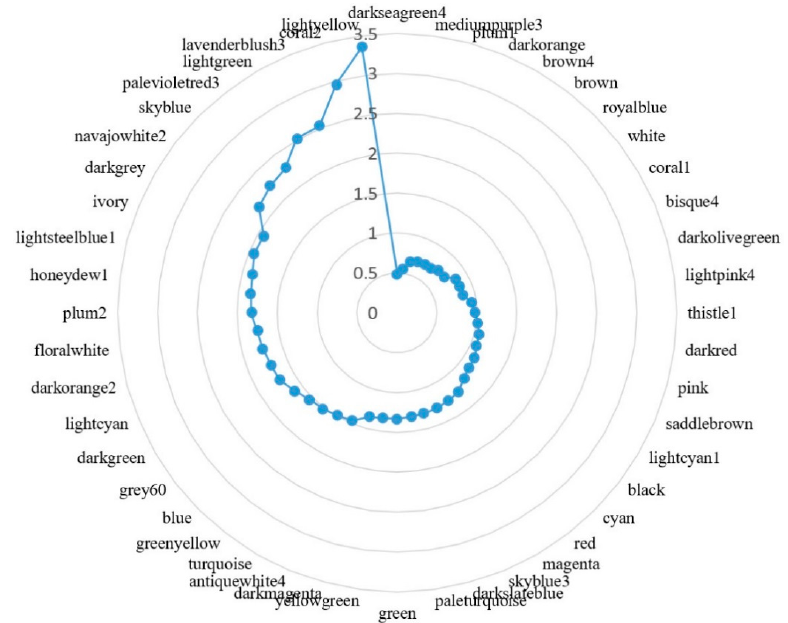
Figure 2. Radar chart showing module ‐ based gene expression variation in C. elegans . The relative standard deviation (RSD) for each gene in a module was calculated, then the module gene expression variation was calculated by averaging the RSD of all genes. The blue dots represent the module RSD from highest (3.5) to lowest (0.5), reading anticlockwise.